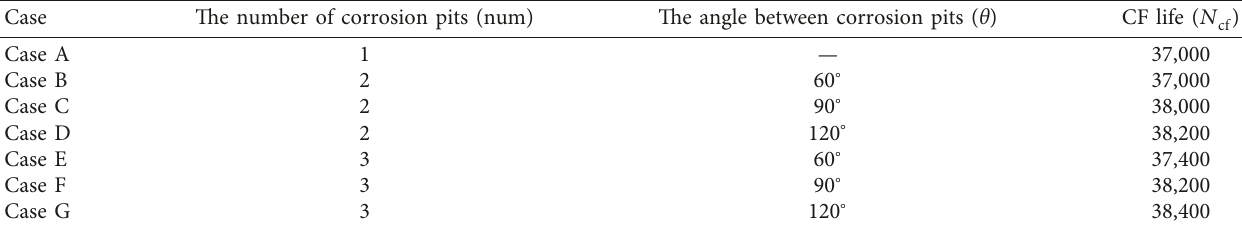
Table 3: CF life of high-strength steel wires with different planar multifatigue sources. Case The number of corrosion pits (num)